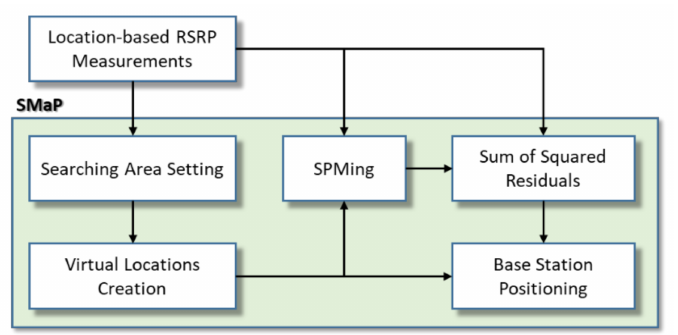
Figure 3. Functional blocks and procedure of SMaP.